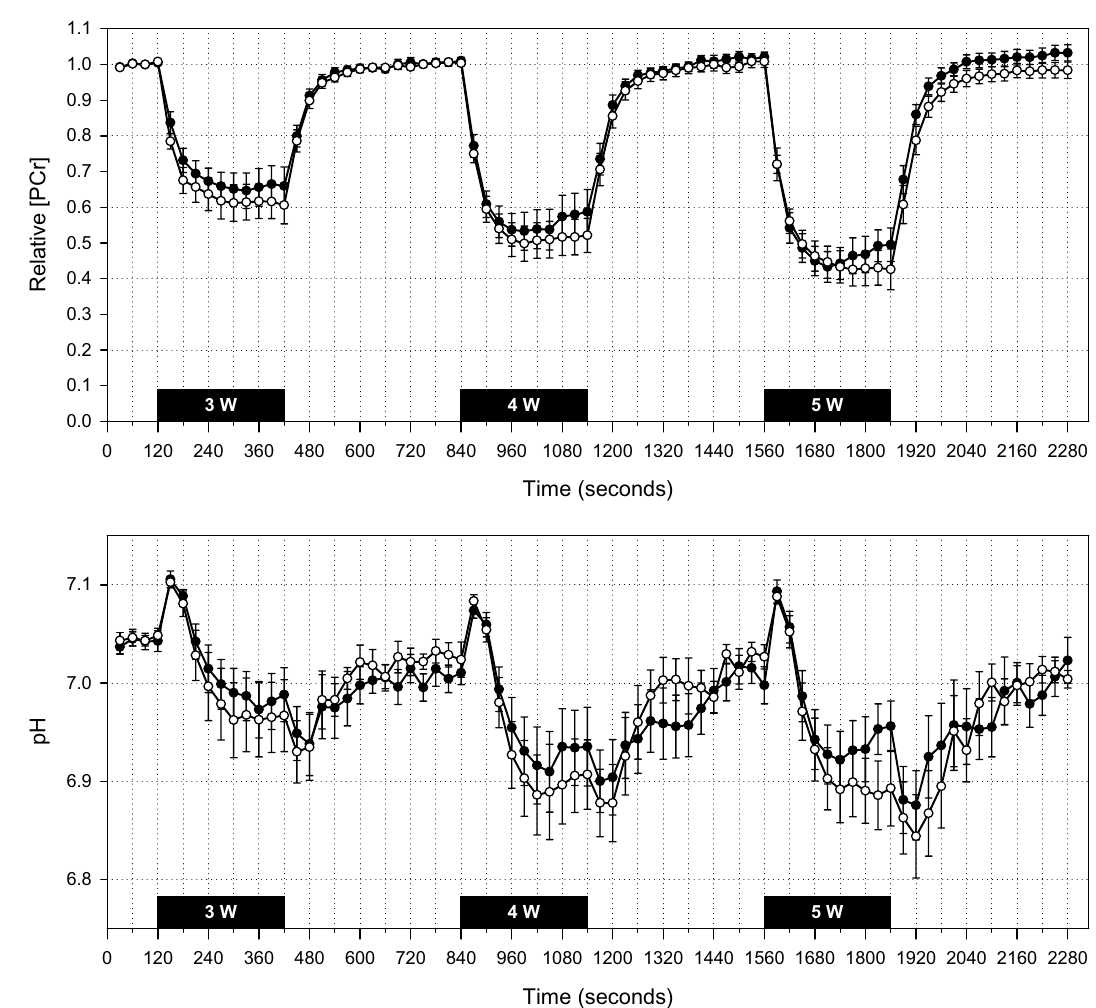
Figure 1. 31 P-MRS data from first study visit. [PCr] is expressed as a fraction of the mean value during the initial 2-min rest period. Data for ID participants appear as white circles; those for IR participants, black circles. Solid black bars indicate 5-min exercise periods. All participants completed the 3-W exercise